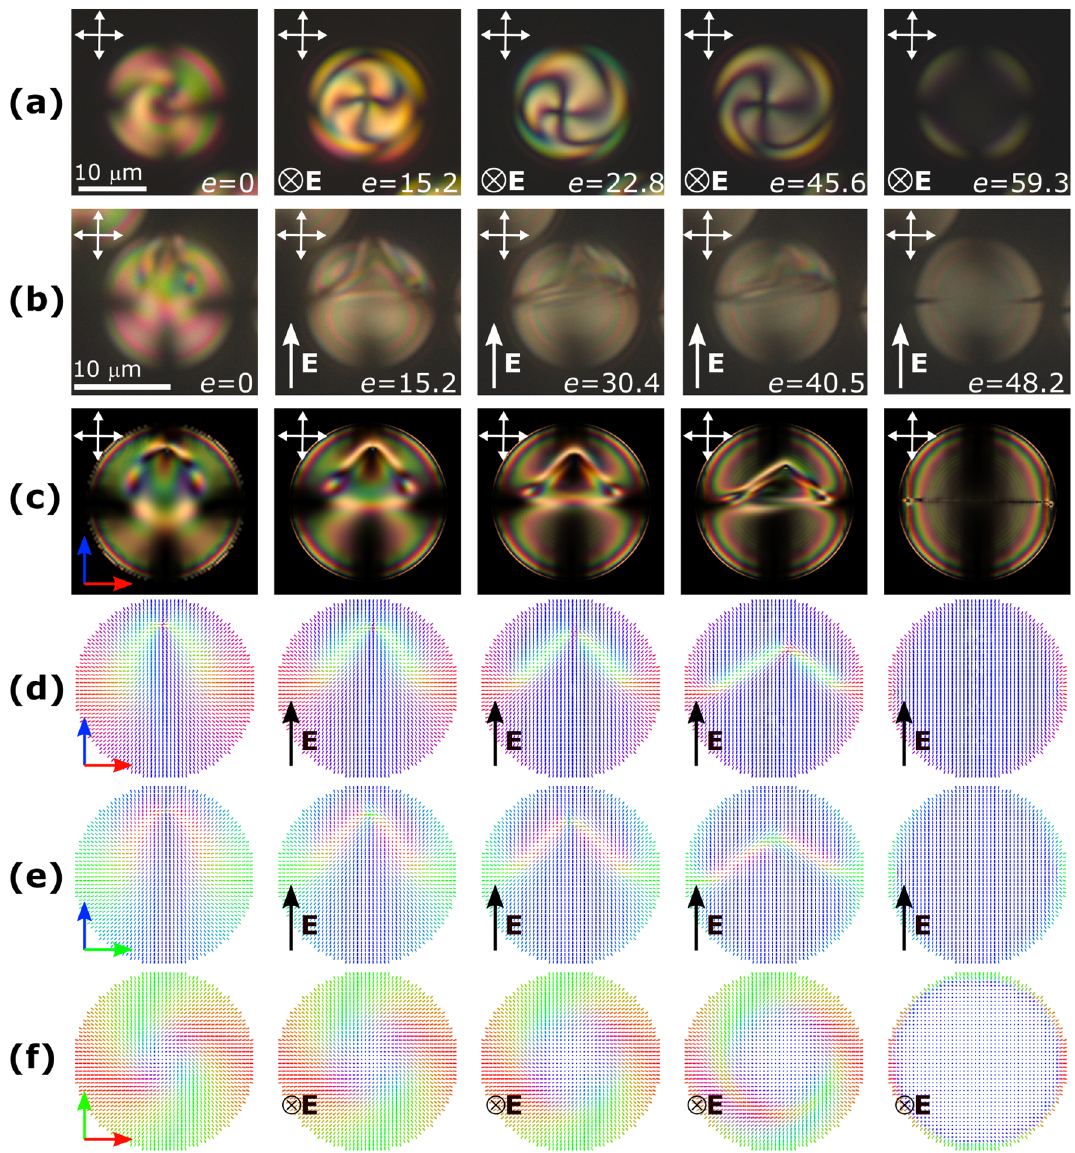
Figure 2. Sequence of structures for the symmetric transition scenario in increasing electric field e = | E | d (ε 0 �ε/ 4 K 11 ) 1 / 2 . Experimental cross-polarized microscopy images for ( a ) symmetry axis perpendicular to the plane, N 0 = 2.2 , and ( b ) symmetry axis parallel to the plane, N 0 = 1.8 . Simulated cross-polarized images ( c ) and director distribution in primary cross cuts ( d – f ) for E7, N 0 = 2.5 . Hereinafter, double arrows indicate the direction of the polarizers, and the director n is colored in correspondence with the direction (red along the x -axis, green along the y -axis, blue along the z